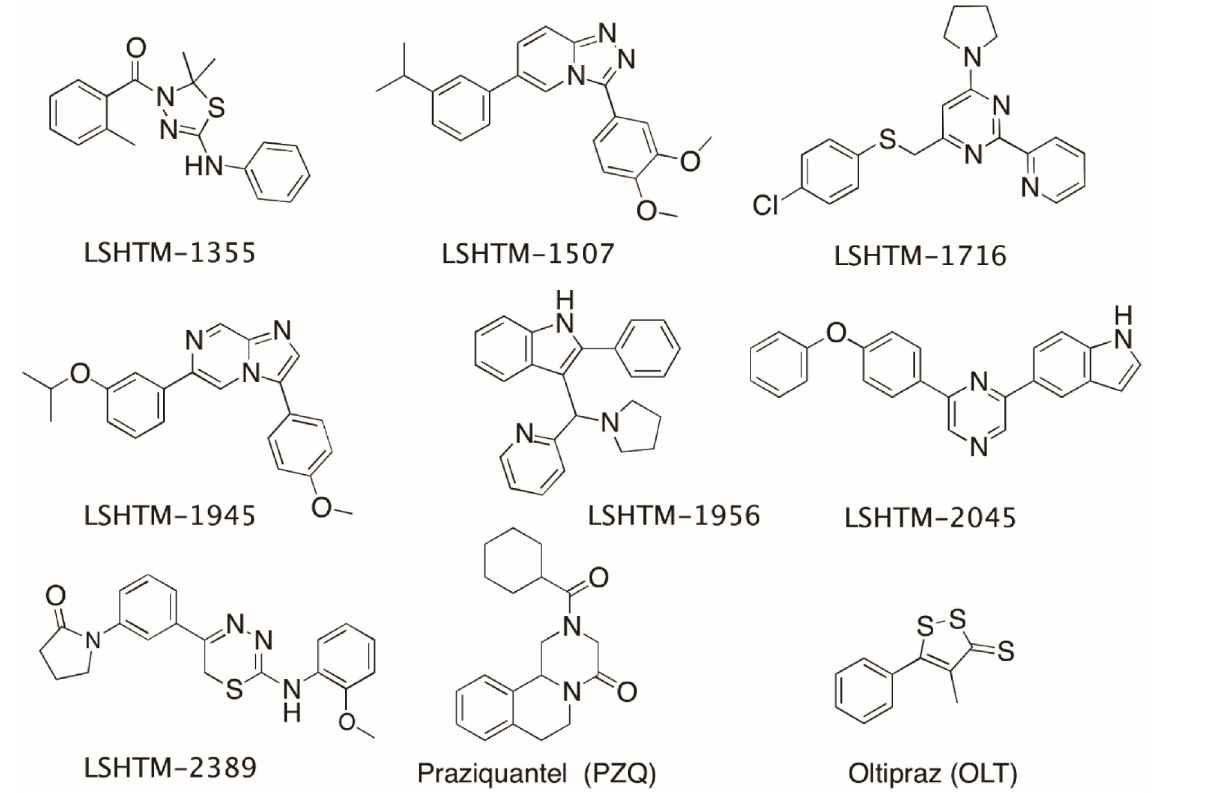
Fig 3. Chemical structures of standard compounds and seven priority compounds selected for further follow up.